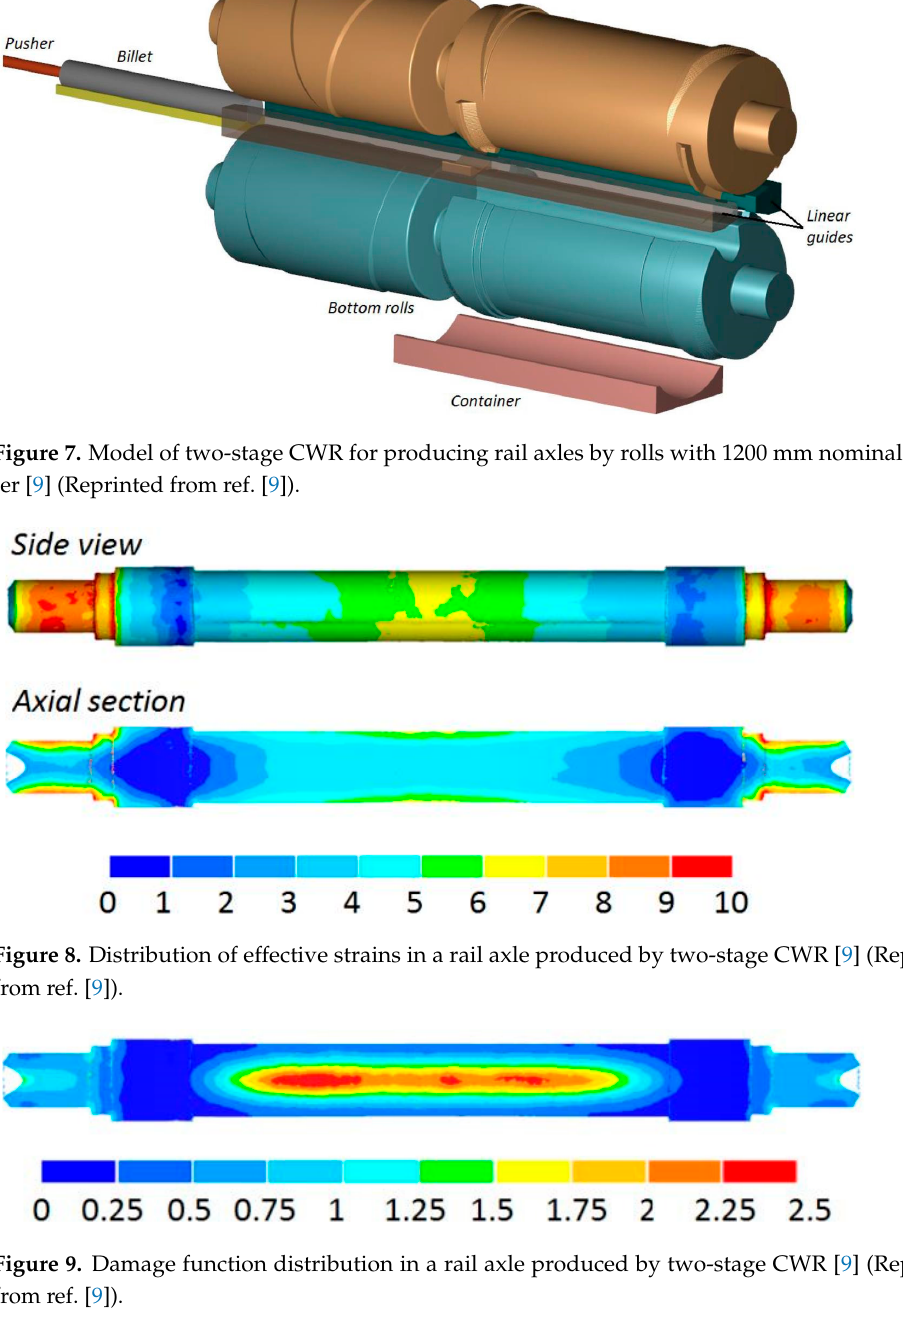
( c ) Figure 6. Hollow axle rolled with MSCWR: ( a ) FE model; ( b ) forming process; ( c ) hollow axle [5] (Reprinted with permission from Ref. [5]. 2023, Springer Nature). 2.2. Multi-Roll Cross-Wedge Rolling for High-Speed-Train Axle Pater et al. proposed a variety of ideas for cross-wedge rolling of railway axles, one of which consists of forming the axle in two steps with two sets of rolls (as shown in Figure 7). The first step includes forming the central step, while the other step involves forming the end step of the railway axle. The FE simulation results ( as shown in Figures 8 and 9)